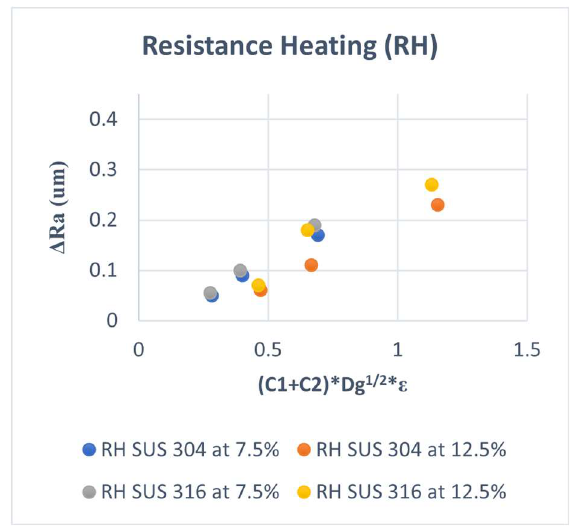
Figure 13. ∆ Ra versus (C1 + C2) × g 1/2 × E at